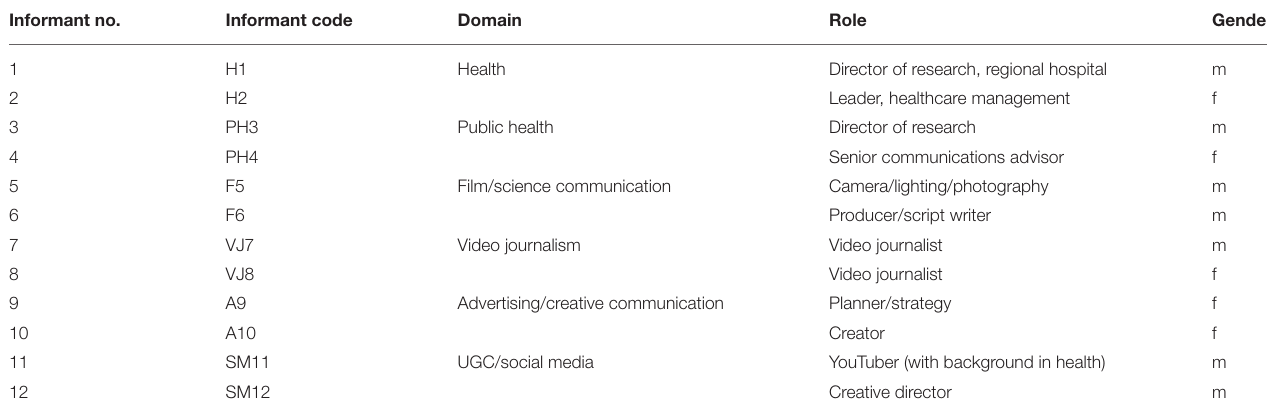
TABLE 1 | Characteristics of the